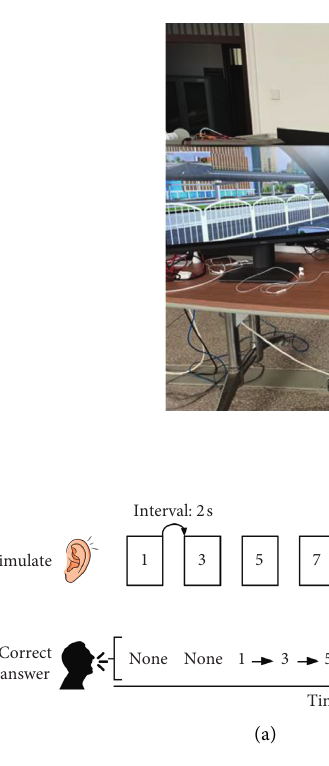
Figure 3: Illustrations of the two cognitive secondary tasks. (a) Two-back task. (b) Clock